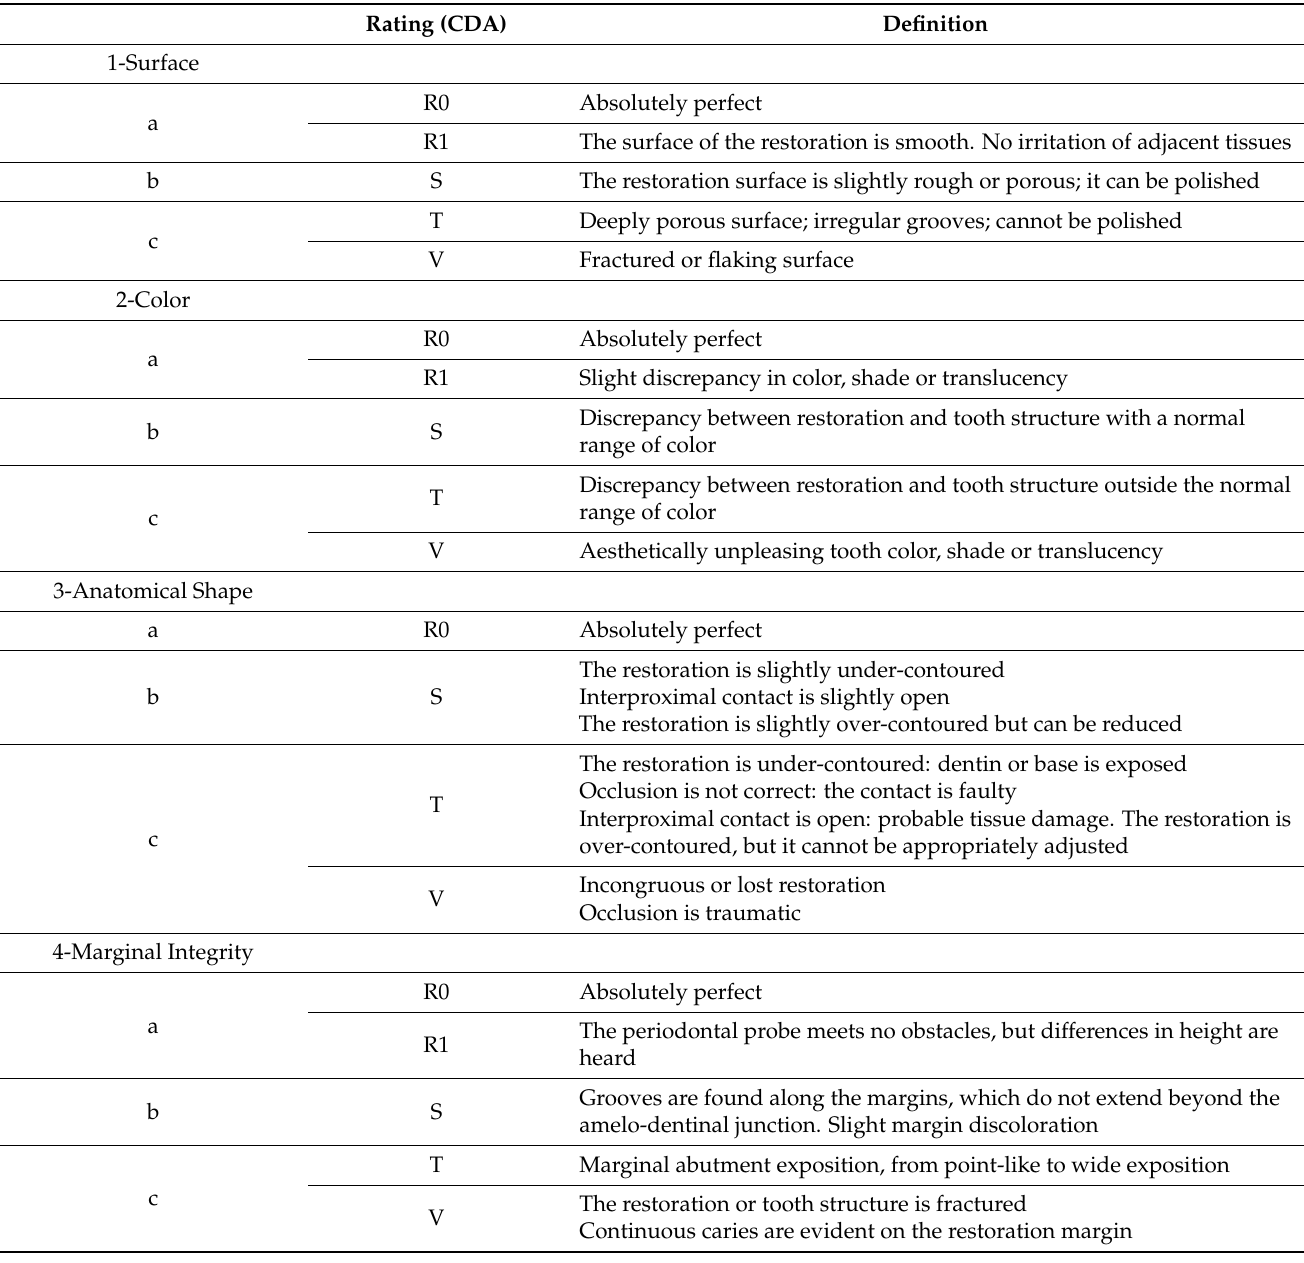
Table 2. CDA rating parameters